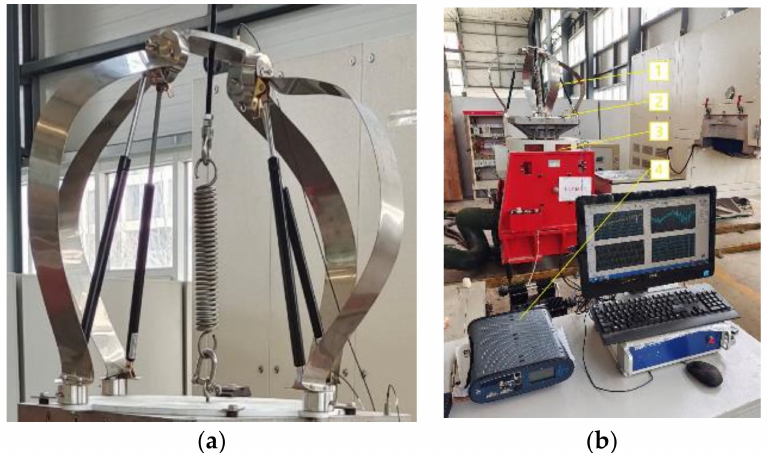
Figure 21. Six degrees of freedom quasi-zero stiffness vibration isolation platform and its test setup: ( a ) the experiment platform; ( b ) test on site ((1) 6-DOF QZS platform; (2) accelerometer; (3) vibrator; (4) acquisition